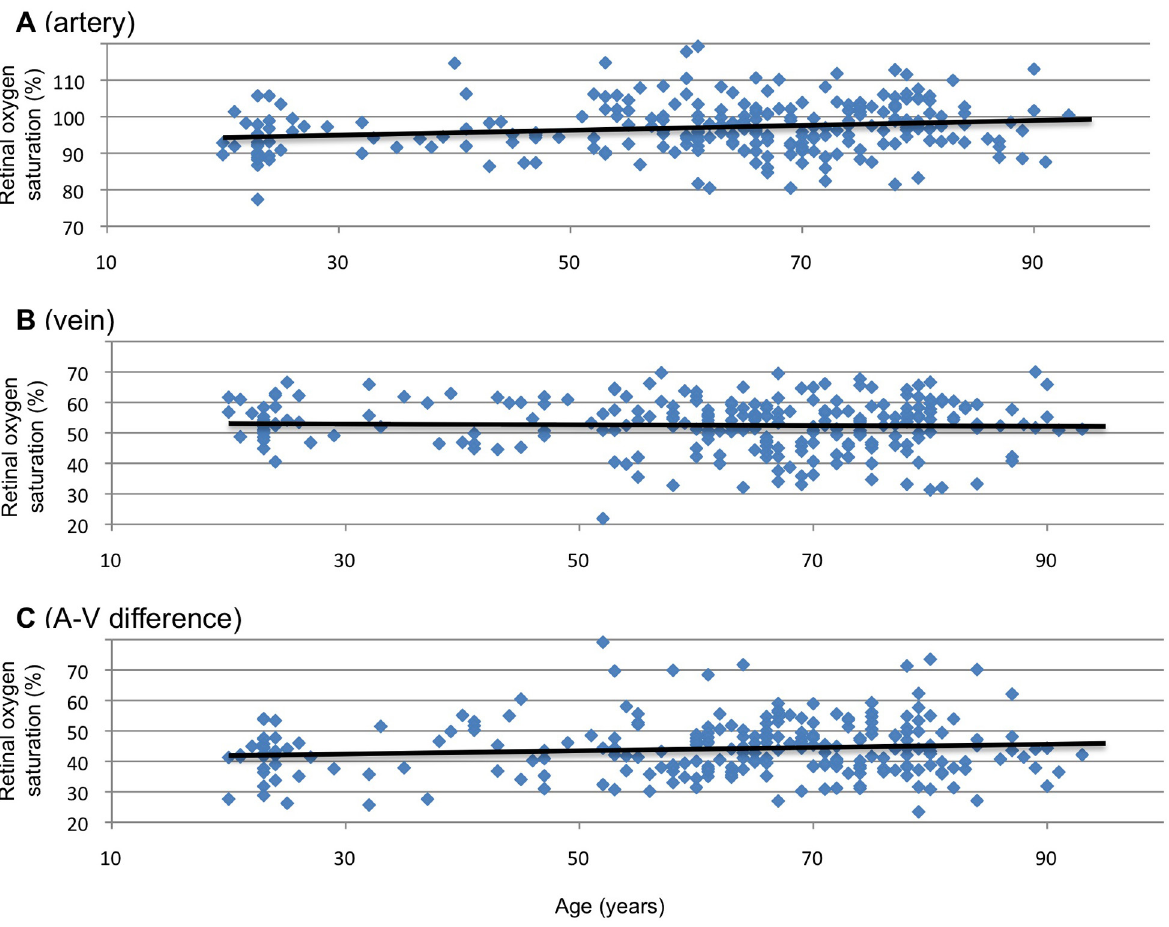
Fig 2. Association between retinal oxygen saturation and age in healthy Japanese. ( A ) Mean oxygen saturation in major retinal arteries in 4 quadrants (r = 0.18, p < 0.01). ( B ) Mean oxygen saturation in major retinal veins in 4 quadrants (r = -0.06). ( C ) Mean arteriovenous (A-V) difference in mean oxygen saturation in 4 quadrants (r = 0.19, p < 0.01).